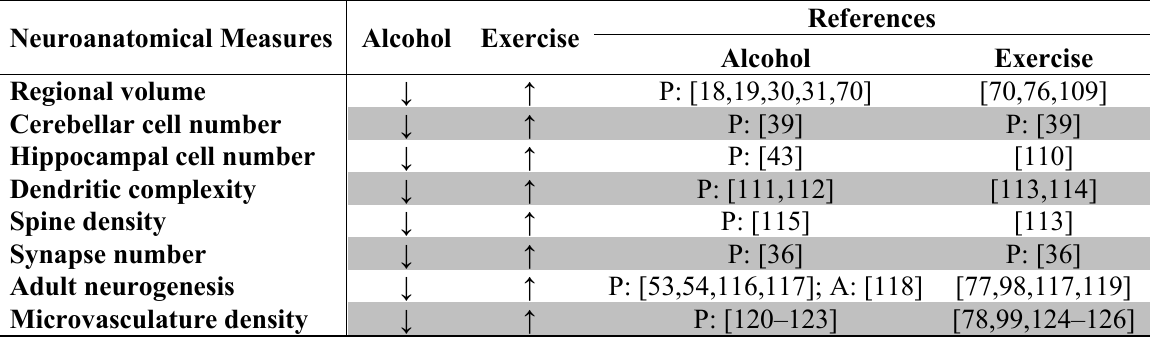
3. Effects neuroanatomical